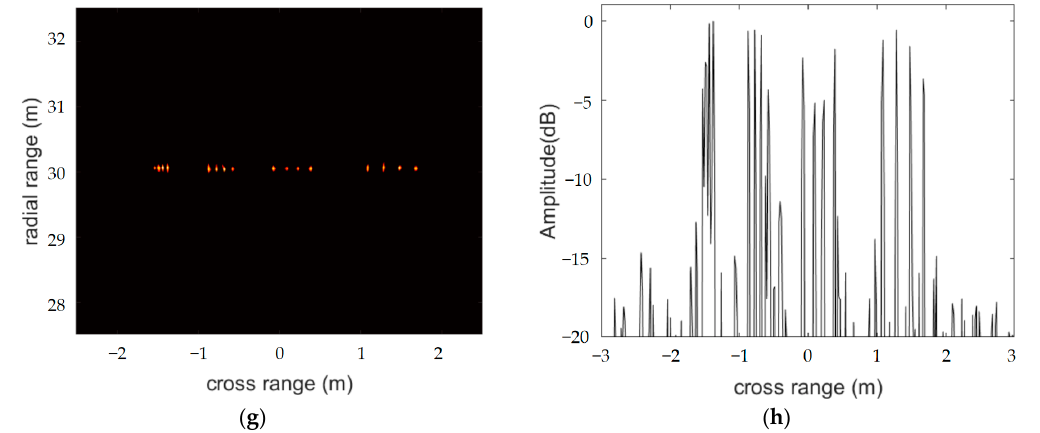
Figure 4. Imaging results and azimuth profiles using the FIAA ( a , b ), OMP ( c , d ), S-ESBL ( e , f ) and LC-SBL ( g , h ) algorithms for a distributed radar system.